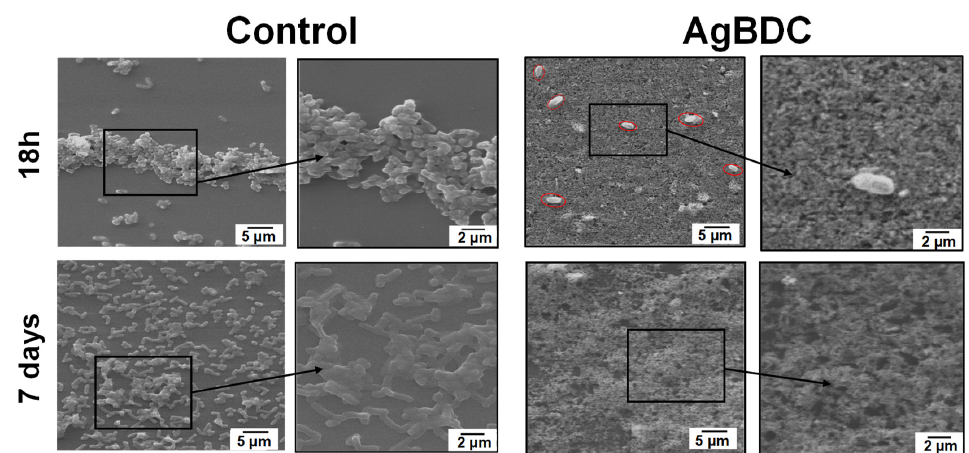
Figure 5. SEM images of E. coli biofilm on cover glass surface: AgBDC coating ( right ) after biofilm growth for 18 h ( up ) and 7 days ( down ) compared with the control ( left ); zoom images (2 µm scale) are highlighted (squared, right ).